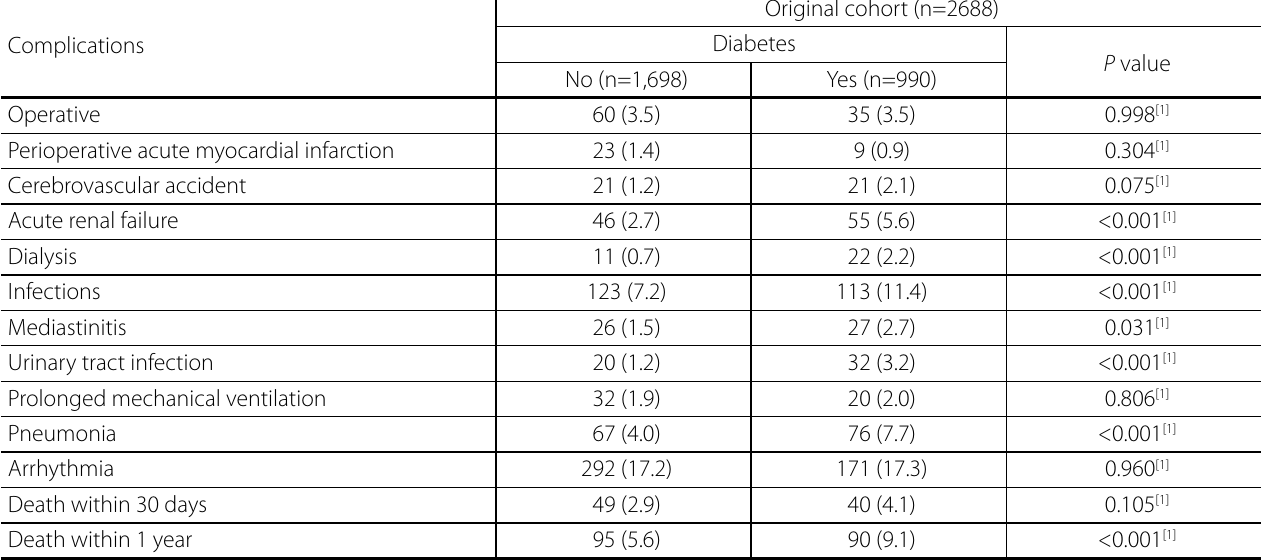
Table 5. Absolute and relative frequencies of complications according to the study